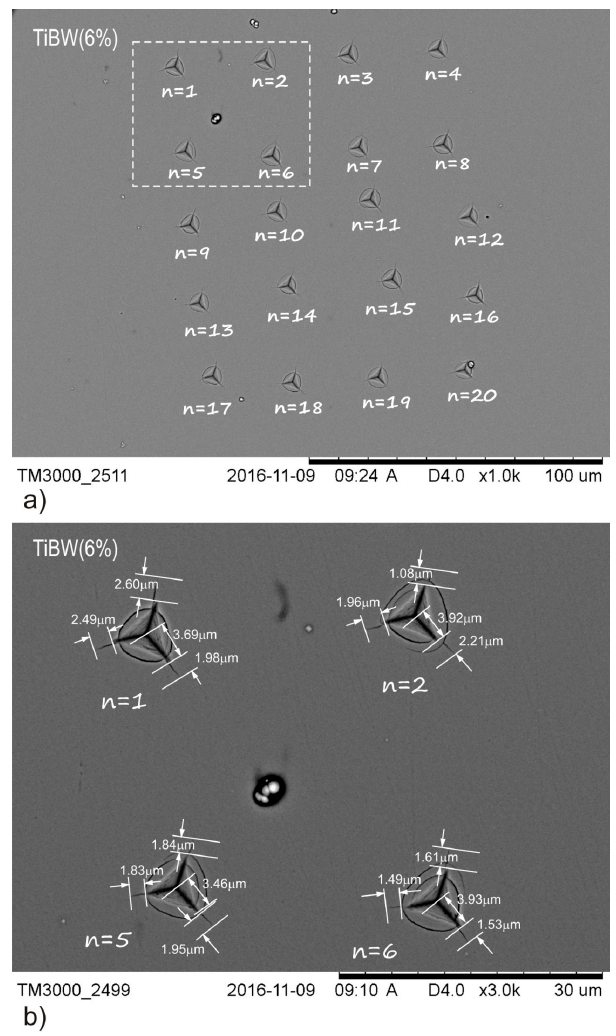
Figure 5. SEM images of groups indentations used for fracture toughness analysis ( K IC ) for Ti-B-W (6%) coating: ( a ) series of 20 indentations with a Berkovich indenter at a load of P = 200 mN; ( b ) dimensional analysis of crack lengths for different indentations where n = 1, 2, 5, 6.